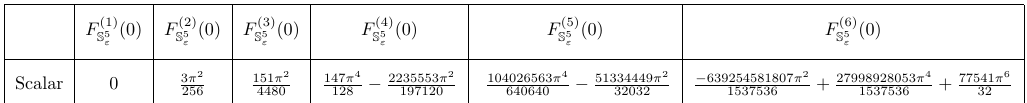
with respect to the squashing parameter " evaluated at " = 0 "